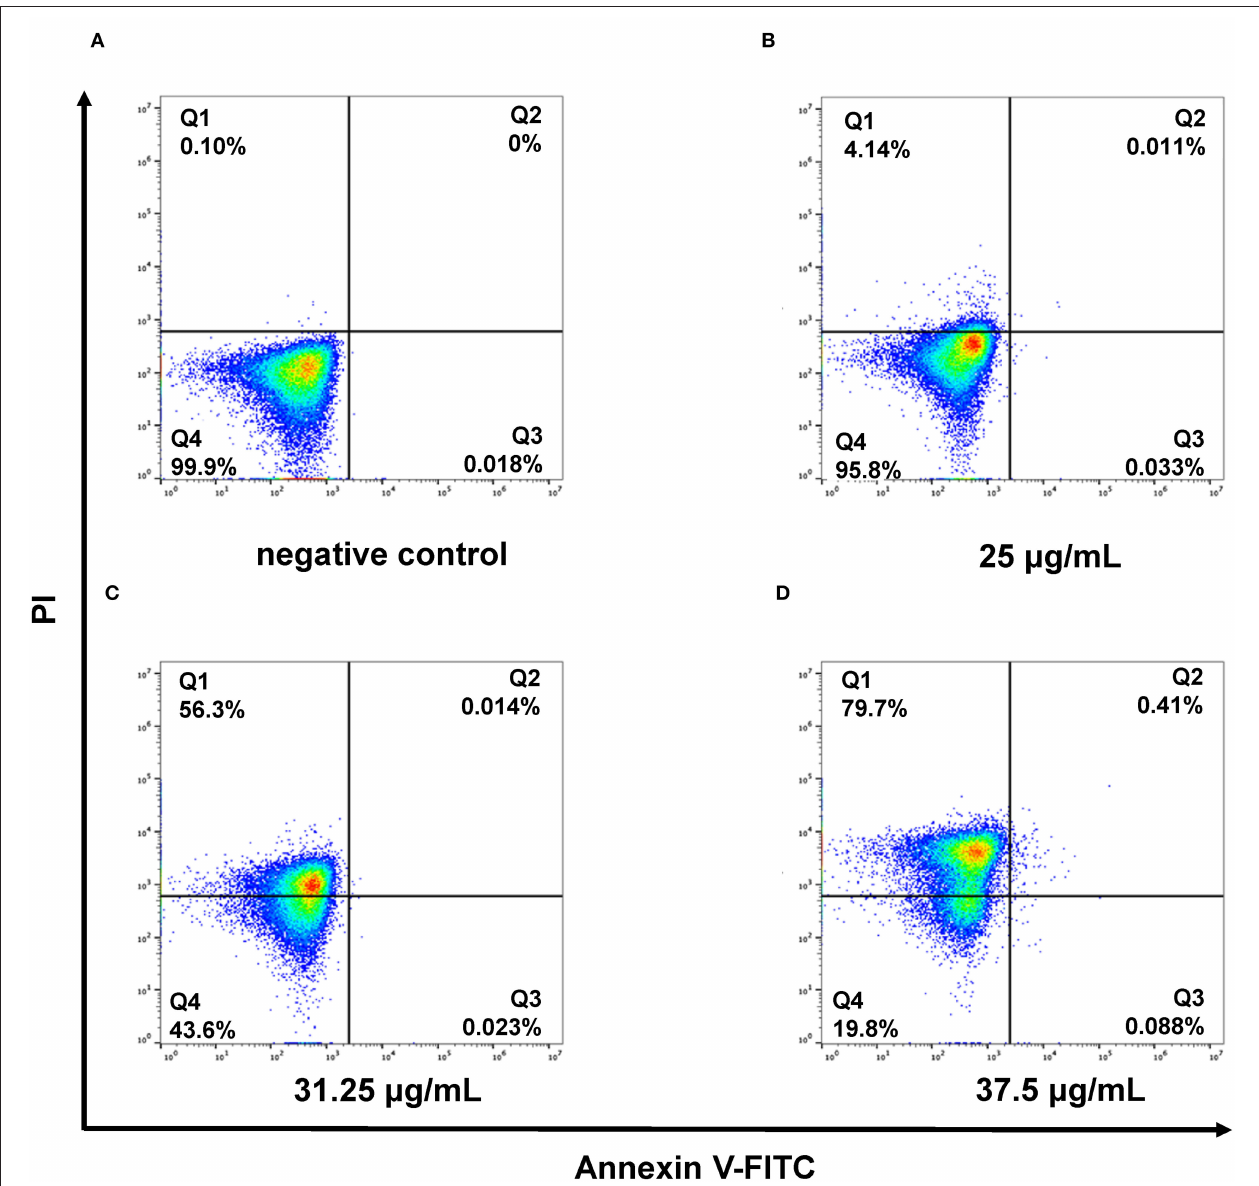
FIGURE 3 | Flow cytometric analysis revealed the necrotic cell death caused by membrane damage in the presence of SAN for 4h in C. albicans (ATCC 10231). Negative control cells without SAN (A) , 12.5 µ g/mL of SAN-treated cells (B) , 31.25 µ g/mL of SAN-treated cells (C) , and 37.5 µ g/mL of SAN-treated cells (D) . Q1: necrosis; Q2: late apoptosis; Q3: early apoptosis; and Q4: